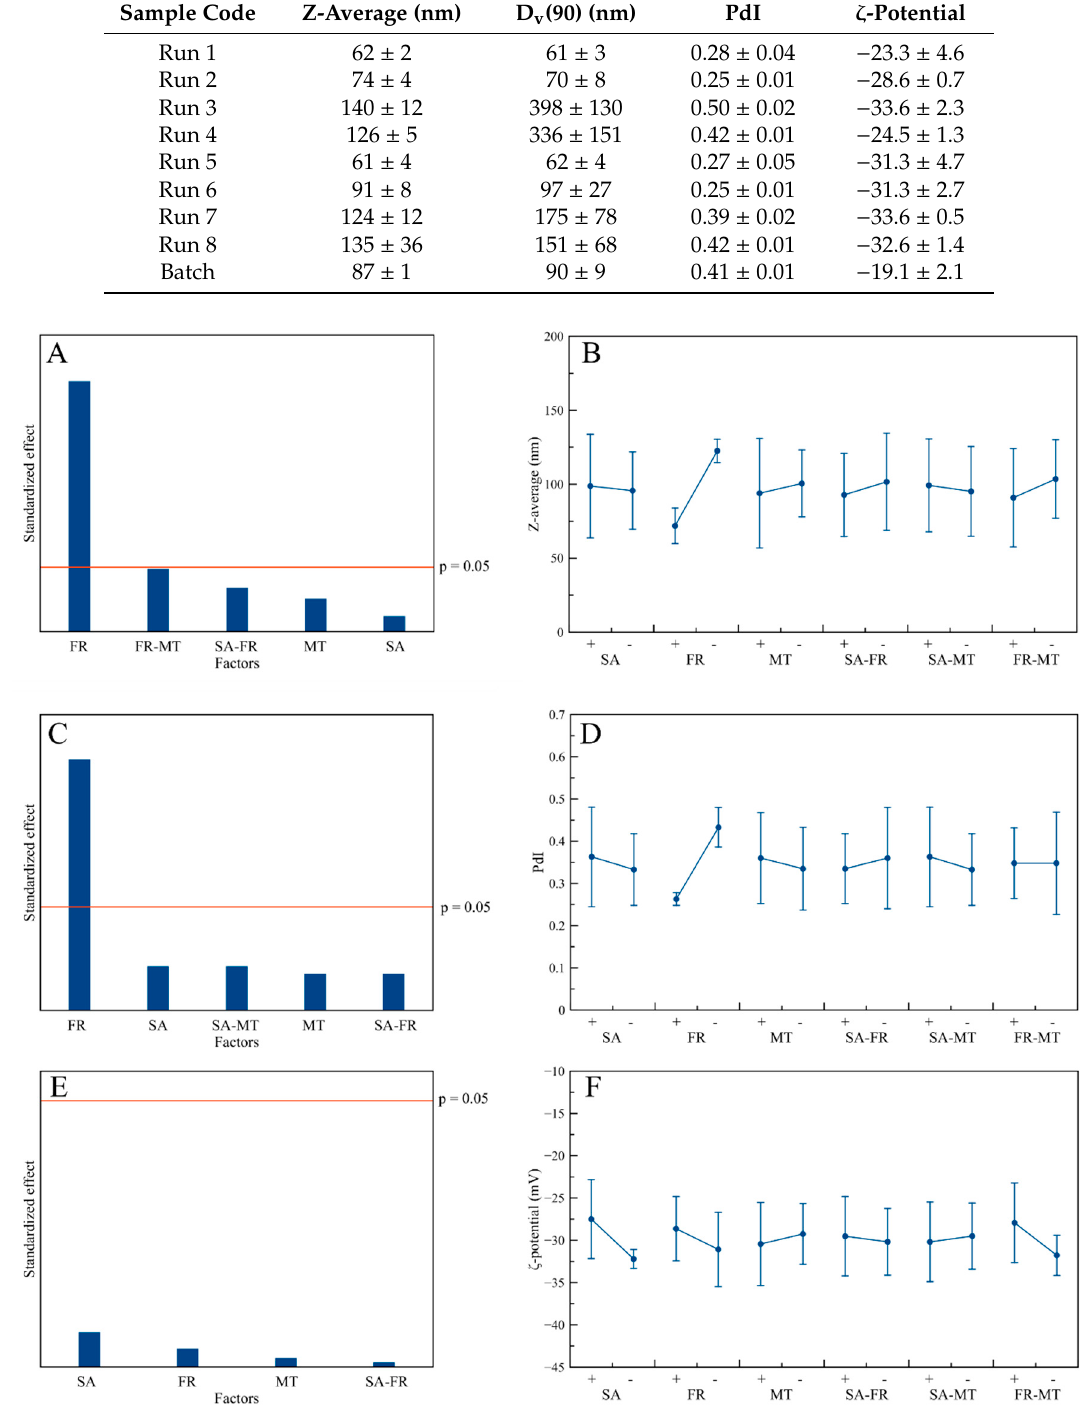
Figure 7. ( A , C , E ) Pareto chart of relevant standardized effects at the confidence limit of 95% and ( B , D , F ) plot of marginal means for ( A , B ) Z-average, ( C , D ) PdI, and ( E , F ) ζ -potential. plot of marginal means for ( A , B ) Z-average, ( C , D ) PdI, and ( E , F ) ζ